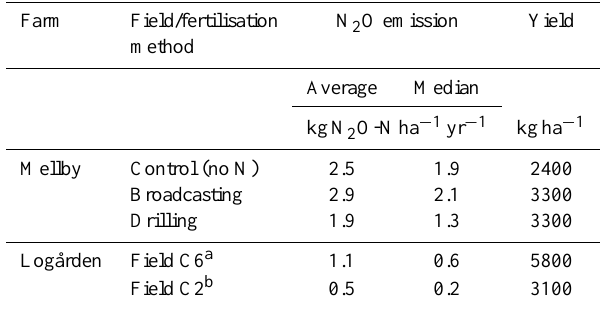
Table 1. Nitrous oxide emissions due to cropping of spring wheat at two Swedish experimental farms.